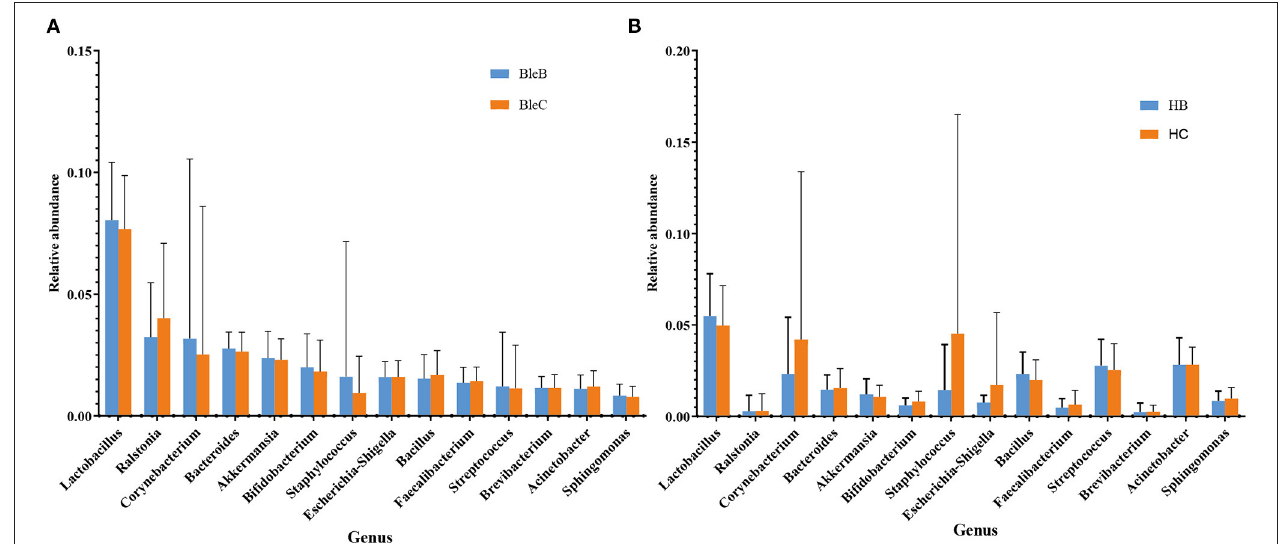
FIGURE 7 | Differences in microbiota composition between the conjunctival sac and eyelid margin. (A) Comparison within the blepharitis group. (B) Comparison within the healthy control